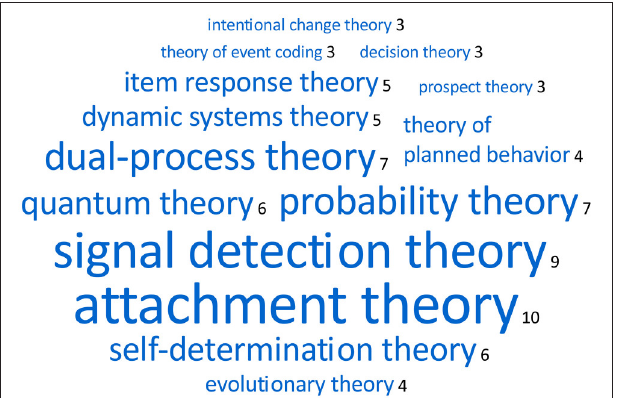
FIGURE 2 | Word cloud of the top 14 theories shared by at least three